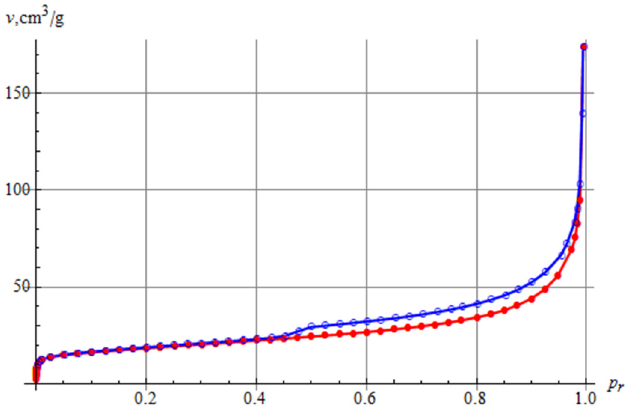
Figure 6. The N 2 adsorption and desorption isotherms for the Pliocene clays studied.